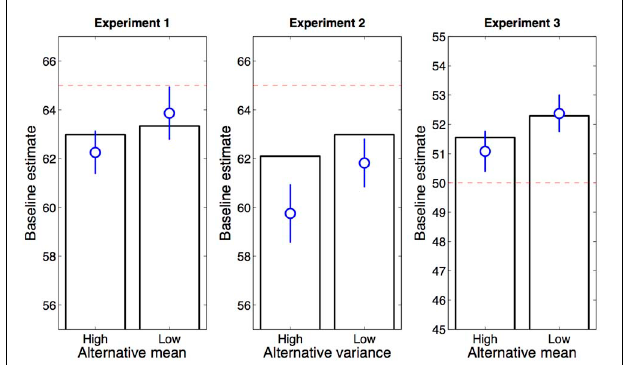
FIGURE 6 | Model predictions. Estimates are derived from the fitted rational model for Experiment 1 ( Left ), Experiment 2 ( Middle ), and Experiment 3 ( Right ). Blue circles show the average guess across trials and participants (error bars represent standard error of the mean). Dashed red lines indicate the true average number of